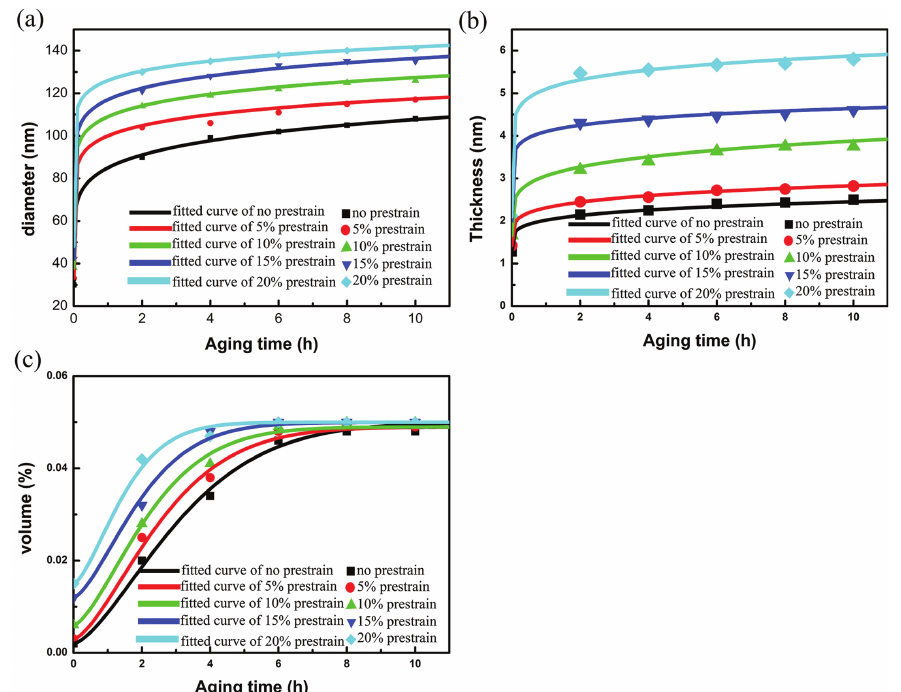
Figure 6: Experimental values and corresponding fitting lines of (a) diameter, (b) thickness and (c) volume fraction of precipitated Ti 2 Cu plates in Ti-2.5Cu alloy sam- ples for duplex